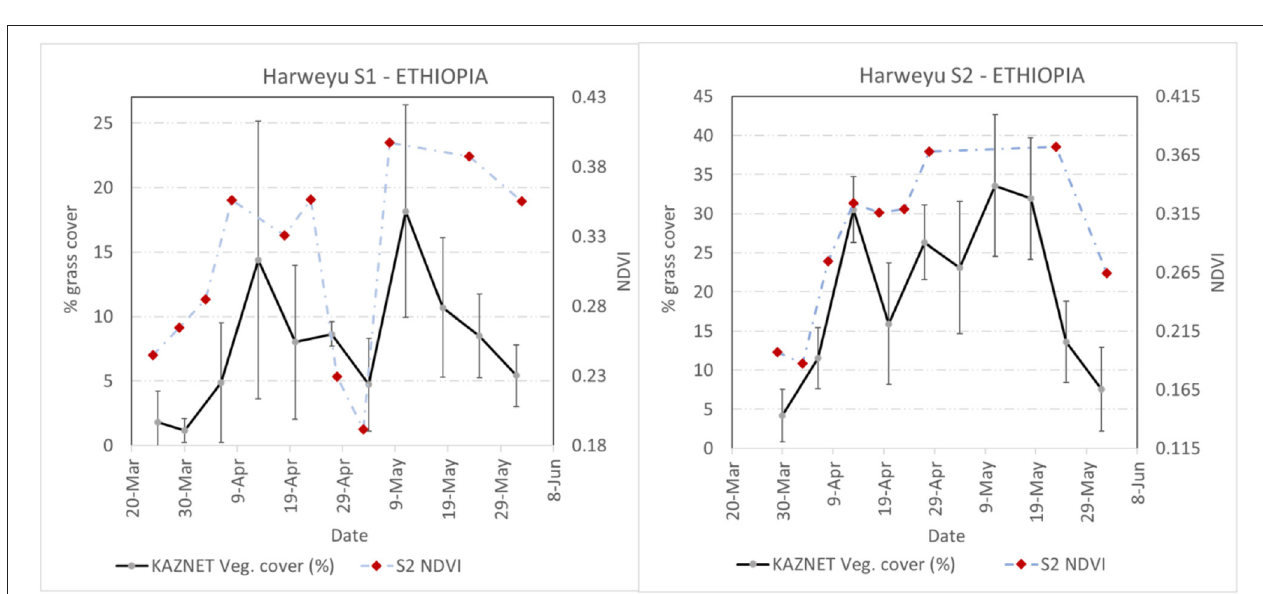
FIGURE 10 | Percent green grass cover estimated from KAZNET for a dry season (S1) and a wet season (S2) pasture in Ethiopia between March and June 2021. Red dots indicate the Sentinel 2 NDVI values acquired over the same sites.